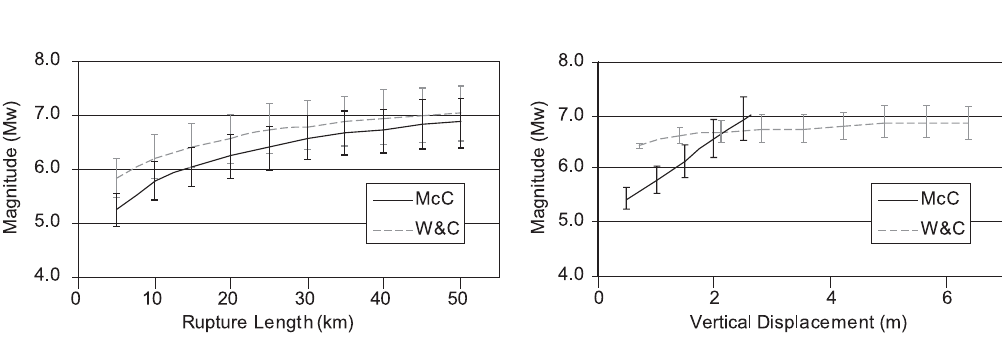
Fig. 5. Comparison of McCue (1990) and Wells and Coppersmith (1994) relationships tying rupture length ver- sus magnitude and displacement versus magnitude. Note that McCue (1990) uses M for magnitudes below 6.0, L . A fault dip of 45 degrees was assumed in order to convert dis- for those above, which approximates M and M S W placement in the Wells and Coppersmith (1994) relationship to scarp height. Error bars are 2 (cid:109)